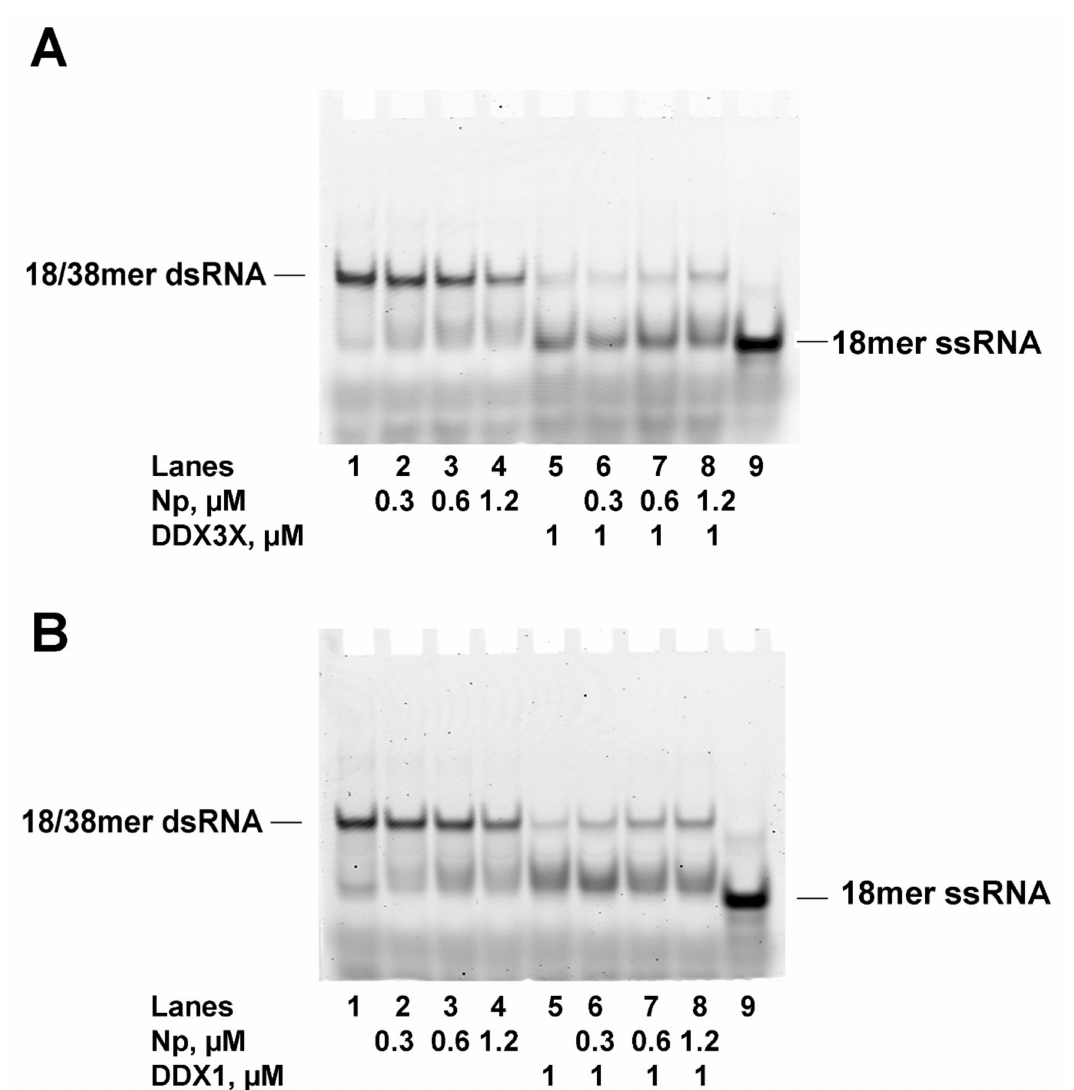
Figure 7. SARS-CoV-2 Np protein inhibits the RNA helicase activity of DDX3X and DDX1. ( A ). Native PAGE analysis of the helicase reaction in the presence of Np alone (lanes 2–4), DDX3X alone (lane 5) or a combination of both (lanes 6–8). Lane 1, control 18/38 mer dsRNA incubated in the absence of proteins. Lane 9, control 18 mer ssRNA incubated in the absence of proteins. ( B ). Native PAGE analysis of the helicase reaction in the presence of Np alone (lanes 2–4), DDX1 alone (lane 5) or combination of both (lanes 6–8). Lane 1, control 18/38 mer dsRNA incubated in the absence of proteins. Lane 9, control 18 mer ssRNA incubated in the absence of